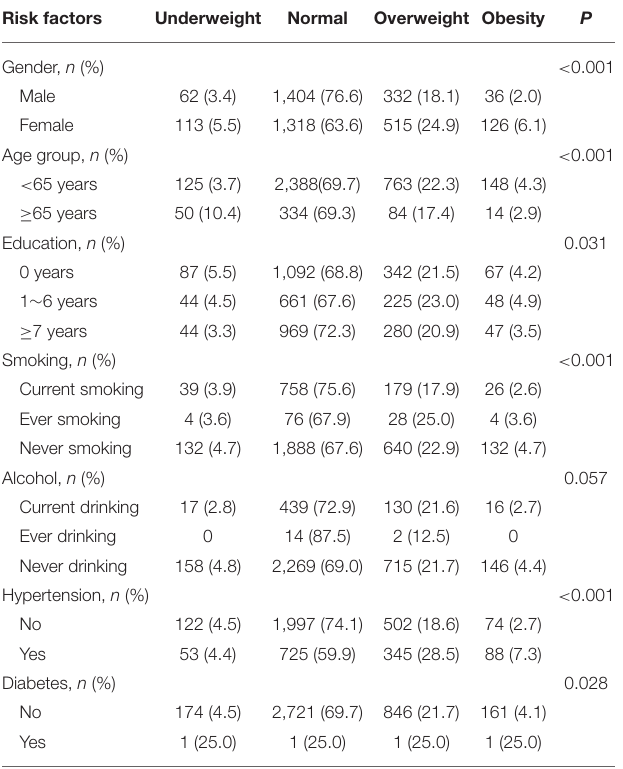
TABLE 2 | Distribution of stroke risk factors in this population at baseline by BMI. Risk